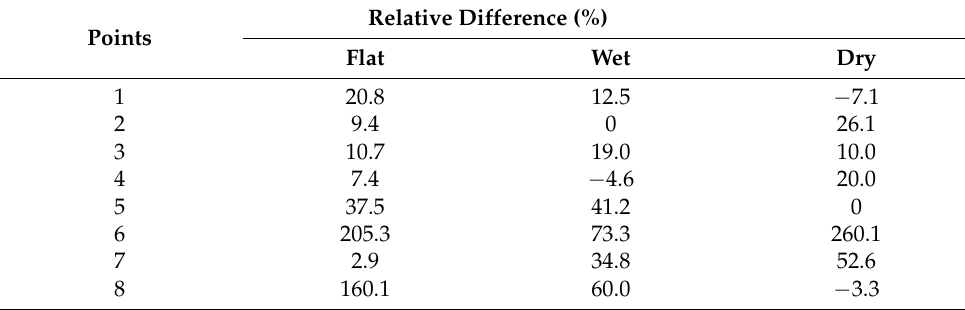
Table 2. Relative difference in TP